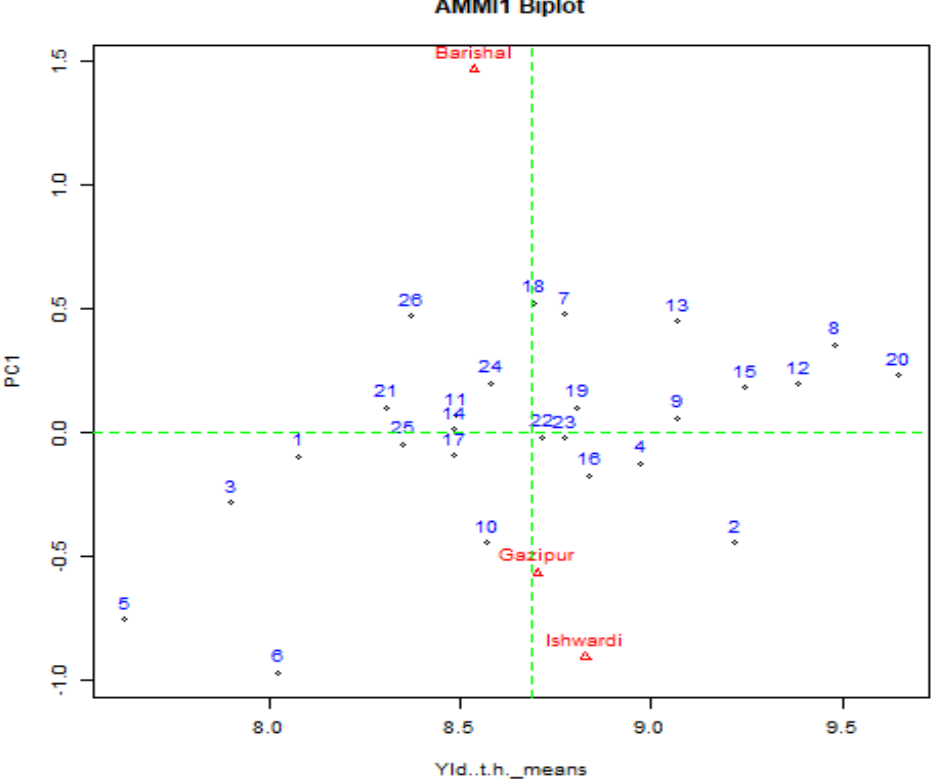
Figure 3. AMMI biplot (genotypes and environments plotted against their IPCA1 scores) for the grain yield of hybrid combinations.